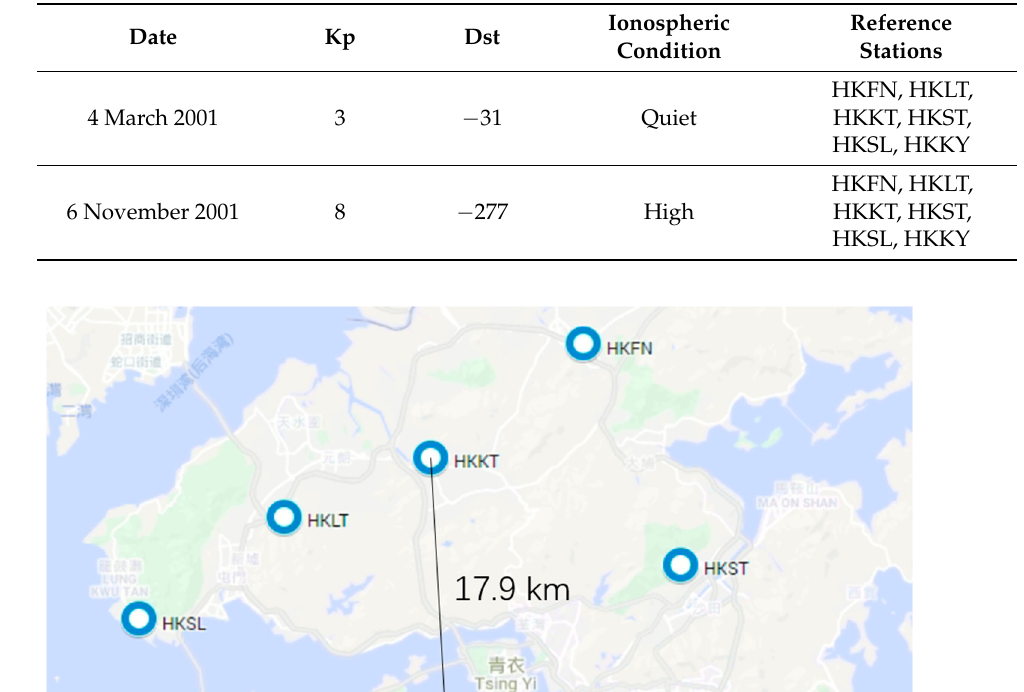
Table 1. Details of testing observation data.